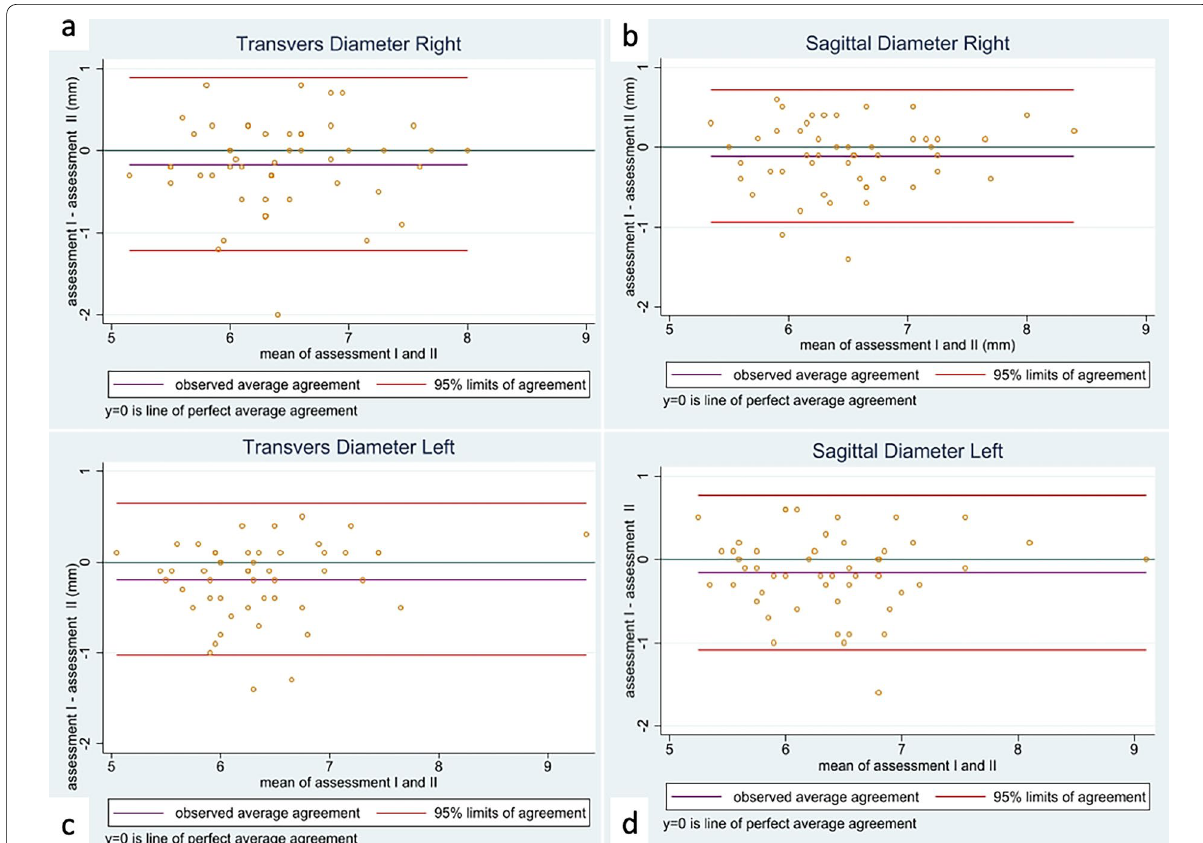
Fig. 2 Bland–Altman plots displaying the intra-rater agreement for neuroradiologist with two sets of measurement in magnetic resonance imaging. The values in the reported axes are in millimeters. a Average difference (violet line): 0.886. b Average difference (violet line): limits of agreement (red lines):